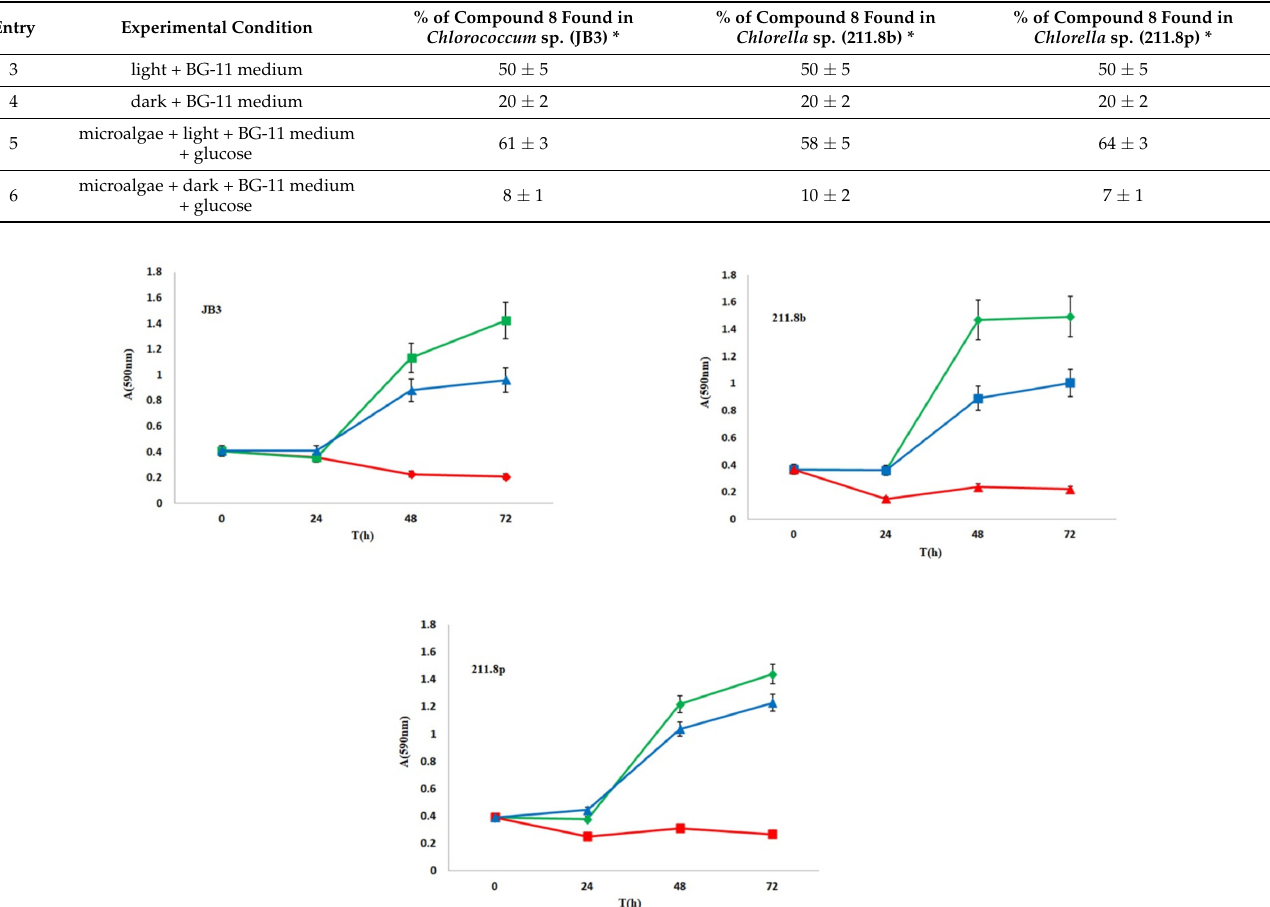
Figure 4. MTT assay on JB3; 211.8b and 211.8p microalgae species. Absorbance at 590 nm is a time function expressed in hours. The green line represents the positive control (not treated); blue line represents microalgae + valencene (3 g/L); red line represents microalgae + CuSO 4 ∙ 5H 2 O (500 mg/L).